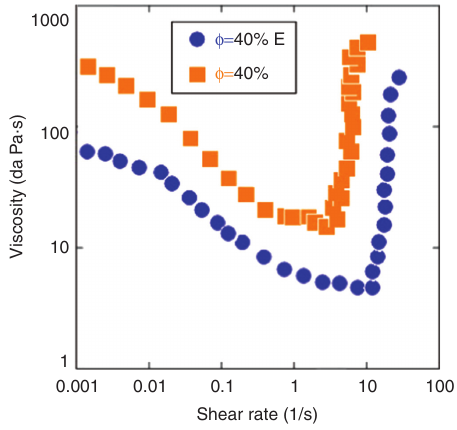
Figure 3 Rheology of STF with ethanol and without ethanol at 40 wt% silica nanoparticle.